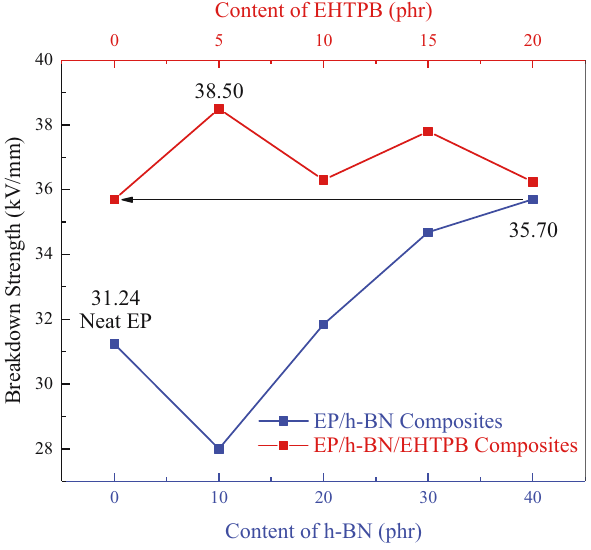
Figure 12: Breakdown strength of EP/h - BN and EP/h - BN/EHTPB